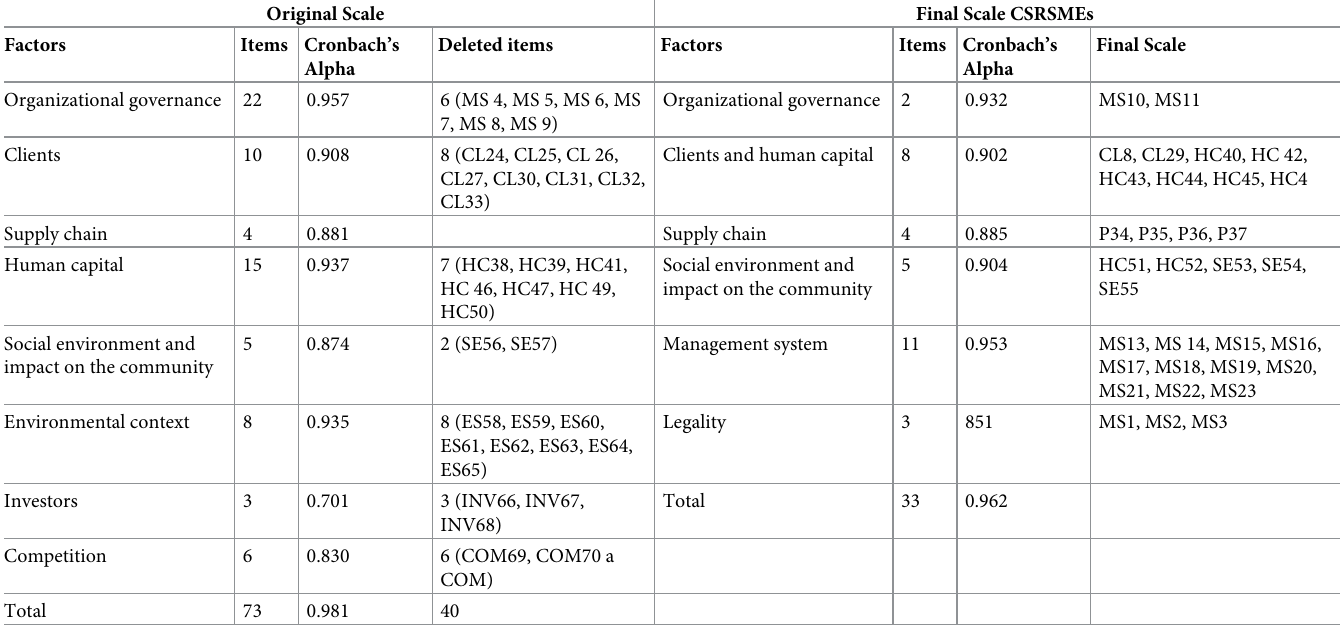
Table 7. Criteria and tests in exploratory factor